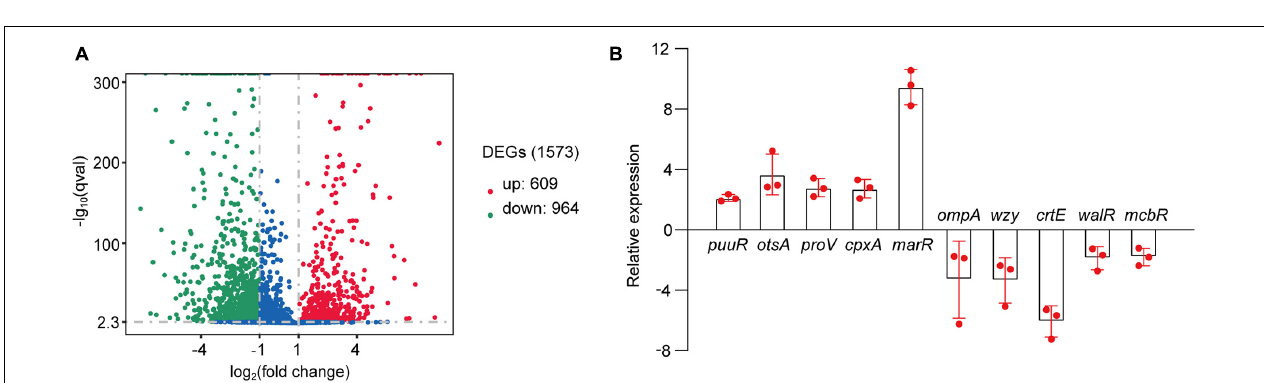
FIGURE 2 | Growth curves and desiccation tolerance of C . sakazakii G4023 and ATCC 29544. (A) Growth curves of C . sakazakii G4023 and ATCC 29544 cultured in LB medium. The overnight cultured bacteria were diluted in the ratio of 1:1,000 (initial inoculum size was approximately 2 × 10 5 CFU) and with shaking. OD600 measurements were performed every 10 min. Both strains entered the logarithmic phase at about 2 h and reached the stationary phase at about 9 h. (B) Progress curve of culturable cell counts during the desiccation of C . sakazakii G4023 and ATCC 29544. The CFU were counted every 5 days, and 50 days of desiccation tolerance was studied in total. ATCC 29544 barely survived, whereas quite a number of G4023 bacteria survived for at least 50 days in desiccation.